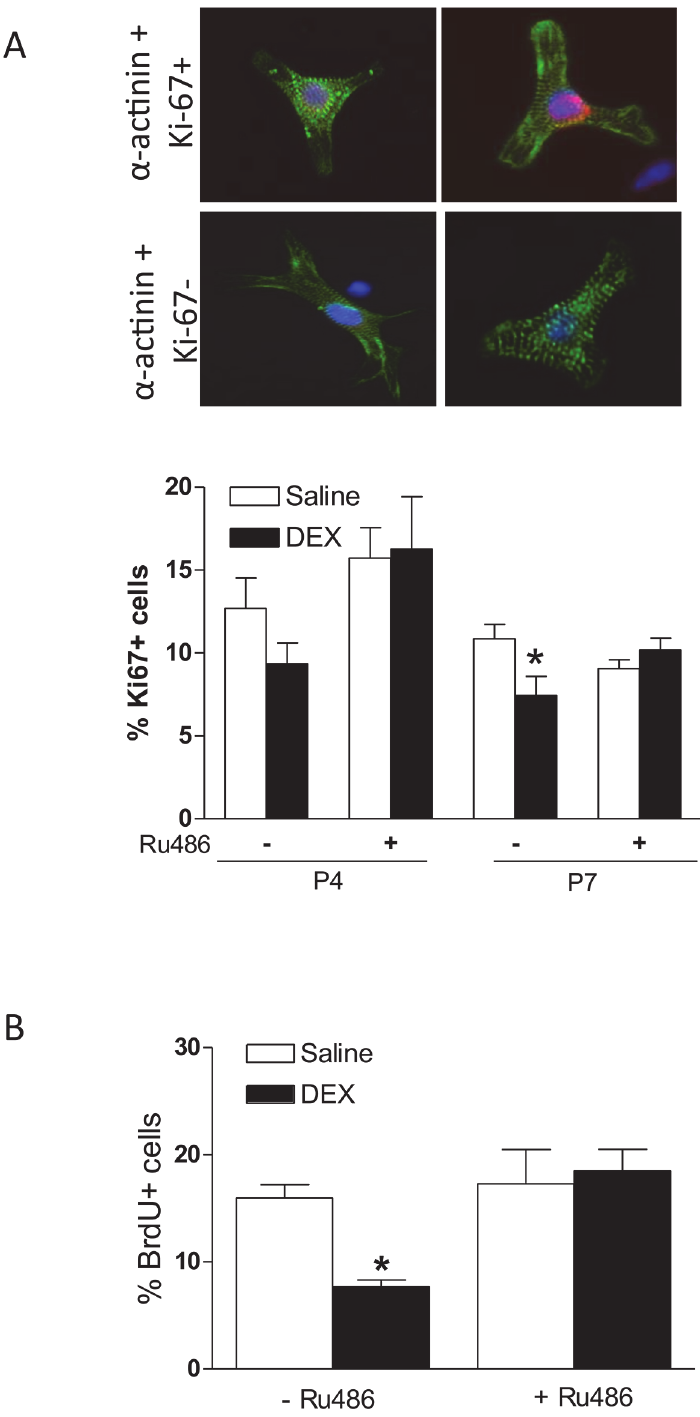
Fig 3. Effect of dexamethasone (DEX) on cardiomyocyte proliferation in neonatal rats. Newborn rats were treated with tapered dose of DEX in the absence or presence of Ru486 during the first three days of postnatal life. Ru486 was administered 30 minutes prior to the DEX treatment. Panel A : Cardiomyocytes isolated from day 4 (P4) and day 7 (P7) neonatal hearts were double stained with α -actinin and Ki67, and nuclei were stained with Hoechst. Representative staining of α -actinin and Ki67 co-localization was shown in the upper panel. Panel B : Cardiomyocytes isolated from P7 neonatal hearts were examined for BrdU incorporation. Data are mean ± SEM, n = 4 – 14. * p < 0.05, DEX vs .